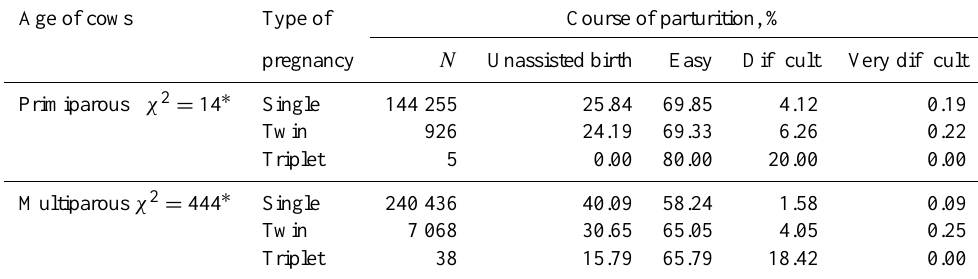
Table 3. Course of parturition depending on the number of calves born. Age of